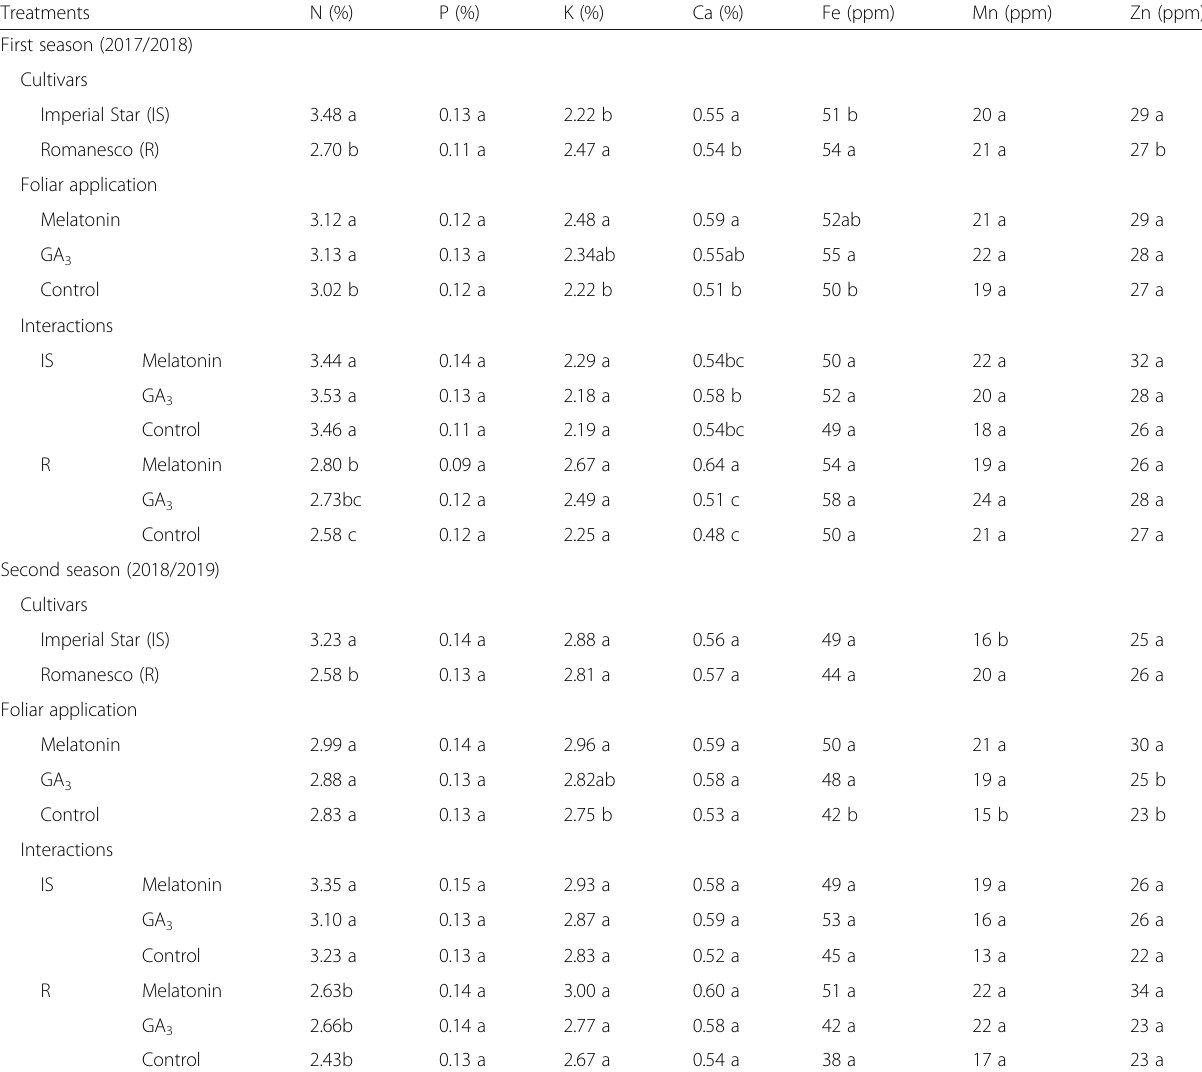
Table 6 Effect of GA 3 and melatonin on head chemical composition of two artichoke cultivars during the two growing seasons